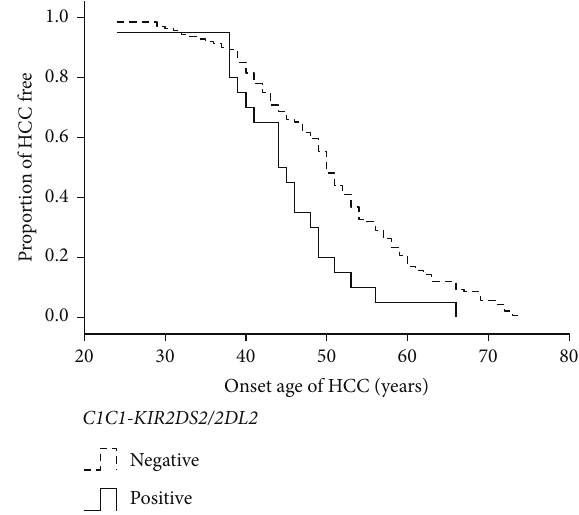
Figure 1: The effect of C1C1-KIR2DS2/2DL2 on the onset age of HCC by KM survival analysis. The plot shows the effect of C1C1- KIR2DS2/2DL2 on the onset age of HCC in males with HBV infection ( 𝑛 = 161 ). C1C1-KIR2DS2/2DL2 positive patients have earlier onset age of HCC ( 𝑃 = 0.004